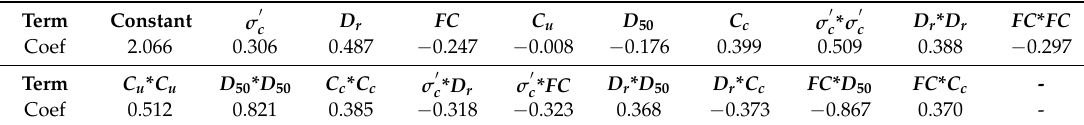
Table 5. RSM equation with the DOE of the BB design, based on the first ANN model (R 2 = 79.83%, R 2 [adjust] = 69.46%).